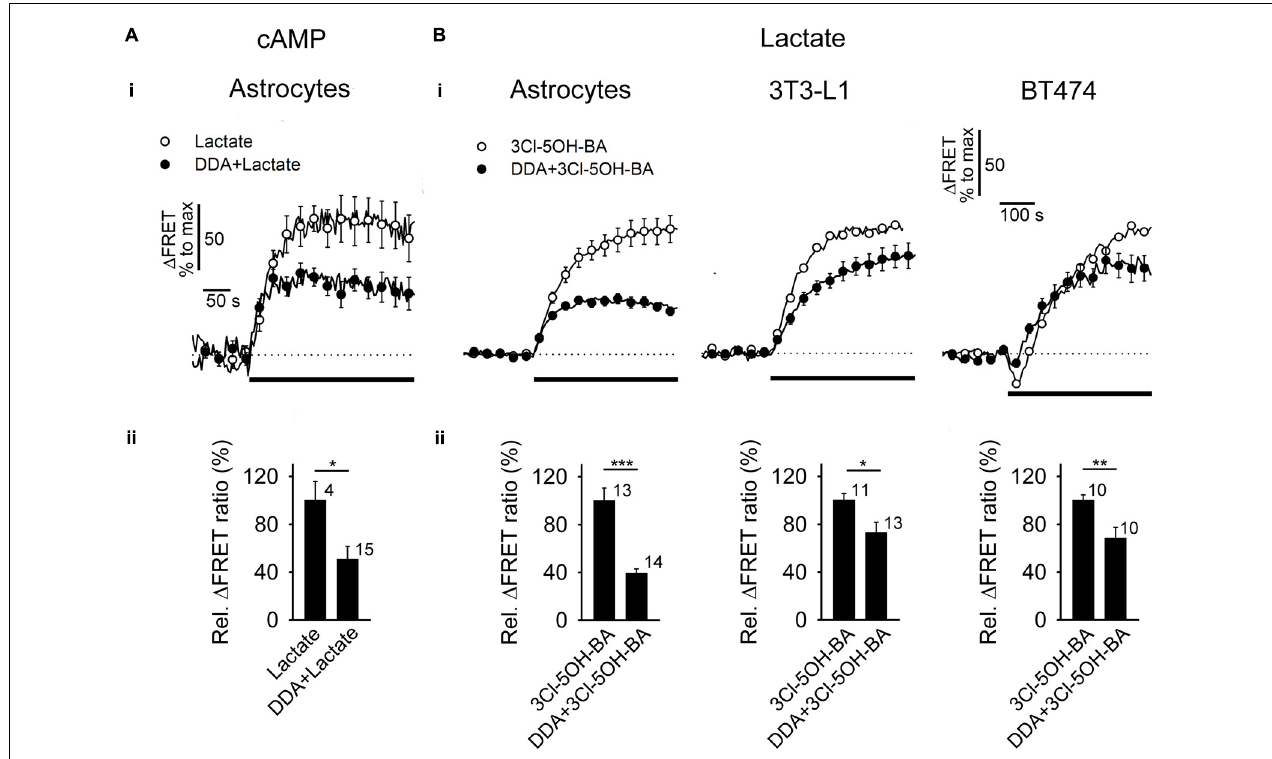
FIGURE 3 | Inhibition of AC reduces the L -lactate- and 3Cl-5OH-BA-induced increase in [cAMP] i and [lactate] i (A,B , panels i) Mean time-courses of FRET ratio signal changes normalized to the maximum signal change for (A,i) Epac1-camps upon addition of 20 mM L -lactate and (B,i) Laconic upon addition of 0.5 mM 3Cl-5OH-BA (black lines) in the absence (white circles) and presence (black circles) of 100 µ M DDA, an inhibitor of AC. Each data point represents mean ± s.e.m. ( A,B , panels ii) Mean relative changes in FRET ratio (Rel. (cid:49) FRET ratio) upon L -lactate (A) and (B) 3Cl-5OH-BA stimulation in the absence and presence of DDA. Relative (cid:49) FRET values (%) were calculated by dividing individual (cid:49) FRET values with the average (cid:49) FRET value upon L -lactate or 3Cl-5OH-BA stimulation. Note that the inhibition of AC by DDA causes ∼ 50 % reduction in L -lactate-induced increase in [cAMP] i in astrocytes and a ∼ 30–60% reduction in 3Cl-5OH-BA-induced increase in [lactate] i in astrocytes, 3T3-L1 and BT474 cells. In BT474 cells the application of 3Cl-5OH-BA initiated a transient reduction in [lactate] i that was diminished in the presence of DDA. Numbers adjacent to black bars represent number of cells. Data are in the format of the mean ± s.e.m ( ∗ P < 0.05, ∗∗ P < 0.01, ∗∗∗ P < 0.001). Data for every set of experiment was acquired from at least two different